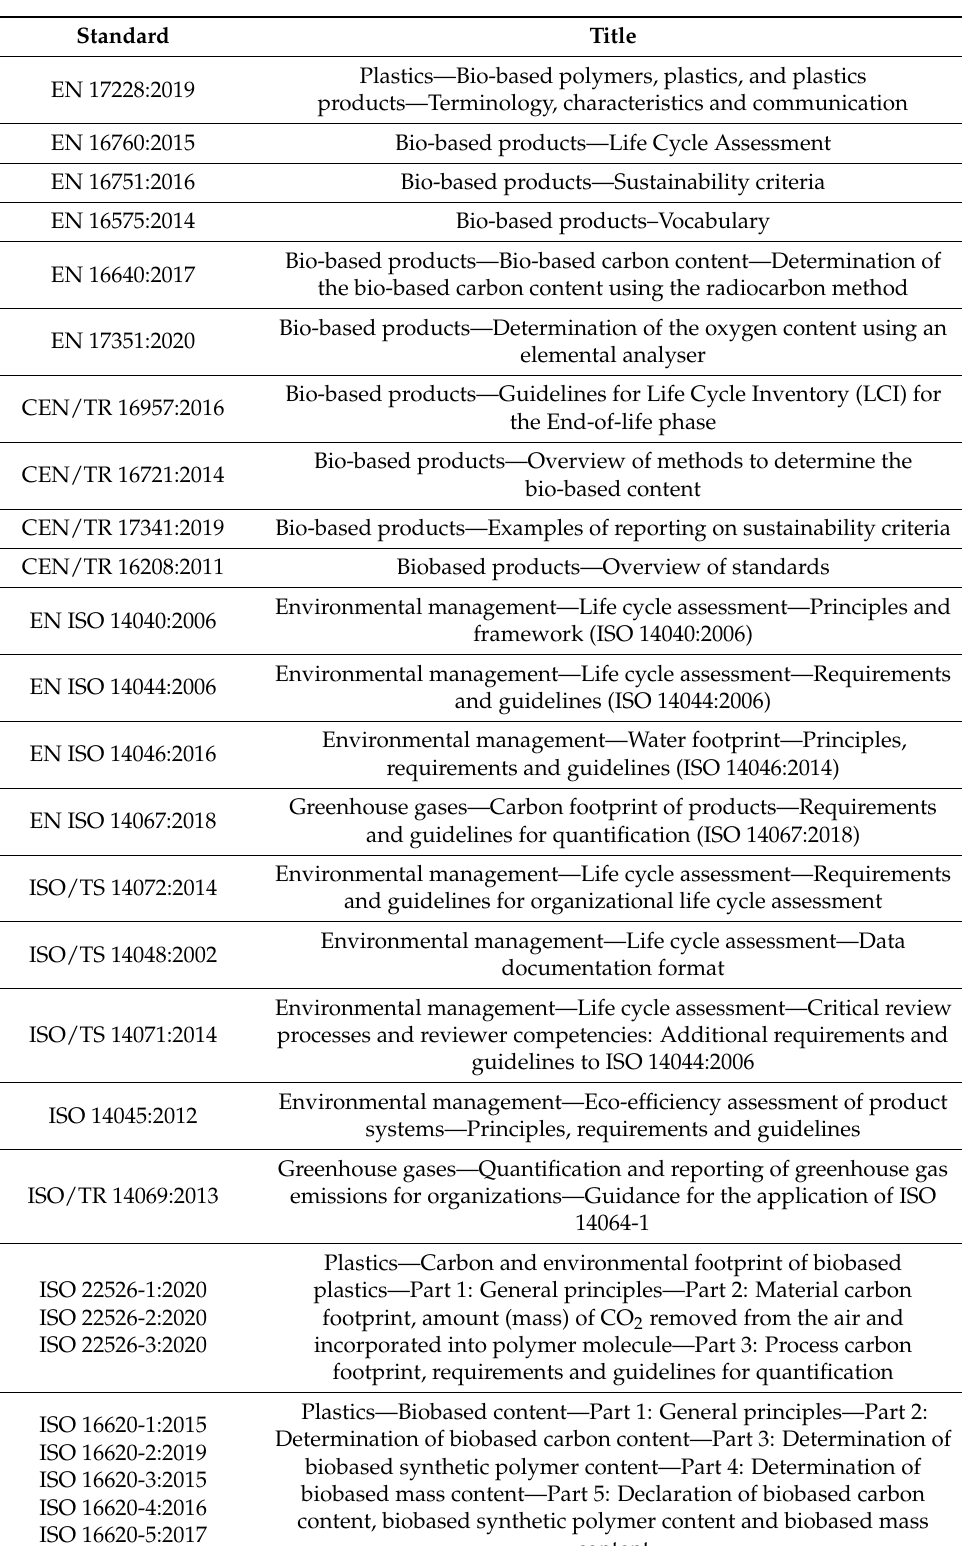
Table 4. List of CEN and ISO standards, technical reports and specifications, relevant to the life cycle assessment of